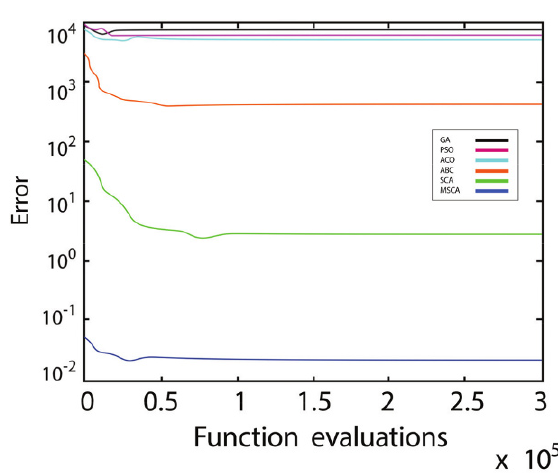
Figure 15. The results of applying different algorithms on F 22 (Con- vergence of Function F 22 for all algorithms).